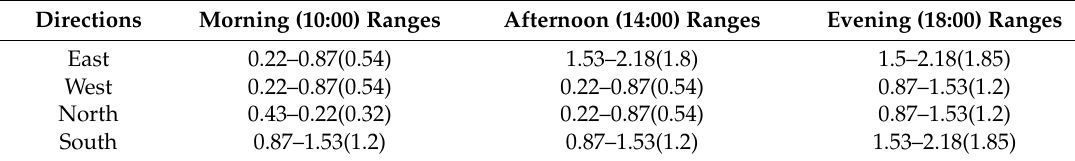
Table 5. Differences in T air at three time points under scenarios A and